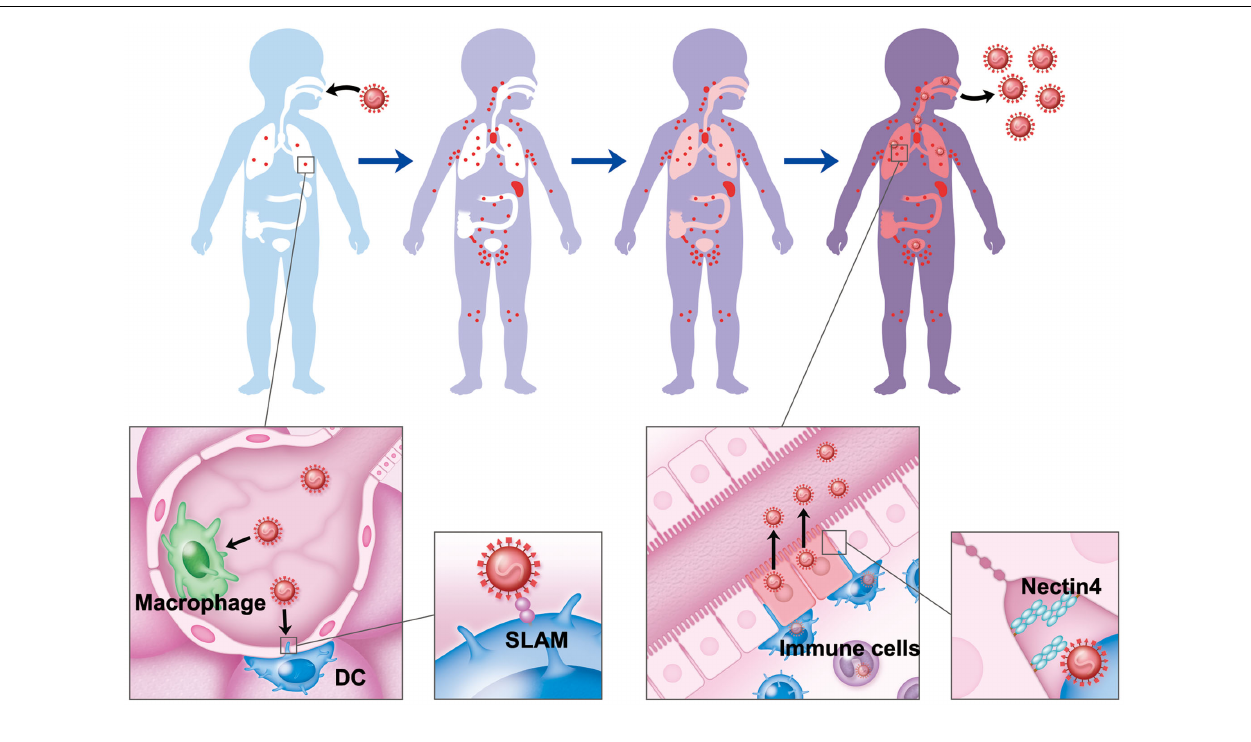
infection of the lymphoid organs reaches its peak, MV-infected immune cells transfer MV to epithelial cells through the basolateral side. At this step, MV uses nectin4 expressed at AJs as a receptor. In the epithelia, MV selectively releases its progeny virus particles from the apical membrane to the luminal side of the respiratory